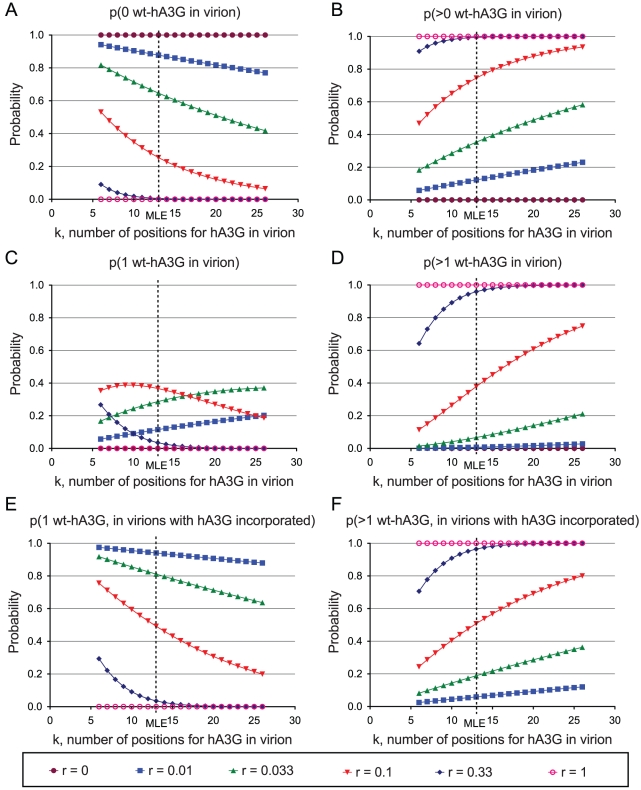
Probabilities of incorporation of editing wild-type hA3G units into progeny virions in the hA3G titration experiment.The sensitivity of the MLE analysis in Figure 1E to each individual condition was assessed by re-estimating k after removing each state in turn. The values of ri, ni, and hi are shown in Table 2. In each case, k refers to the hypothetical number of positions within a virion that could be occupied by wt-hA3G units that can induce hypermutation; r denotes the proportion of wt-hA3G in the titration experiment (the proportion of non-editing E259Q-mutant hA3G is 1−r). Probabilities for each of the values of k spanning the 95% C.I. of the maximum likelihood estimate of the number of wt-hA3G units are shown (MLE = 13; 95% C.I. = 6–26), and are based on the binomial distribution. (A–D) Probabilities of virions incorporating (A) zero wt-hA3G units, (B) at least one wt-hA3G unit, (C) exactly one wt-hA3G unit, (D) two or more wt-hA3G units, for each model are shown. (E–F) graphs depicting the probability of hypermutation having been caused by (E) a single wt-hA3G unit, or (F) more than one wt-hA3G unit.